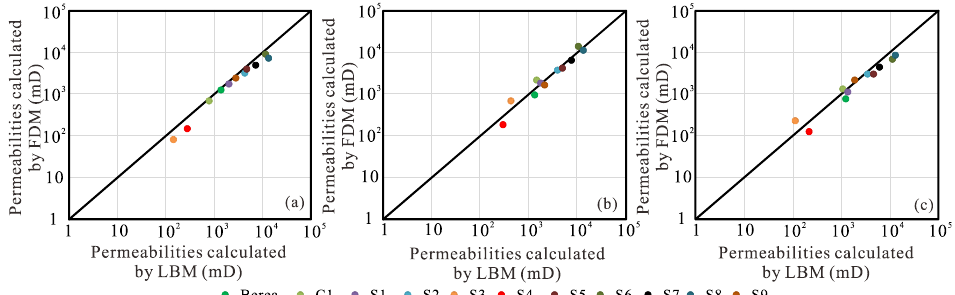
Figure 23. Comparison between the permeabilities calculated by LBM and IFDM for digital rock images after grid coarsening three times or four times. ( a ) Permeabilities calculated in macroscopic flow direction of x ; ( b ) Permeabilities calculated in macroscopic flow direction of y ; ( c ) Permeabilities calculated in macroscopic flow direction of z .